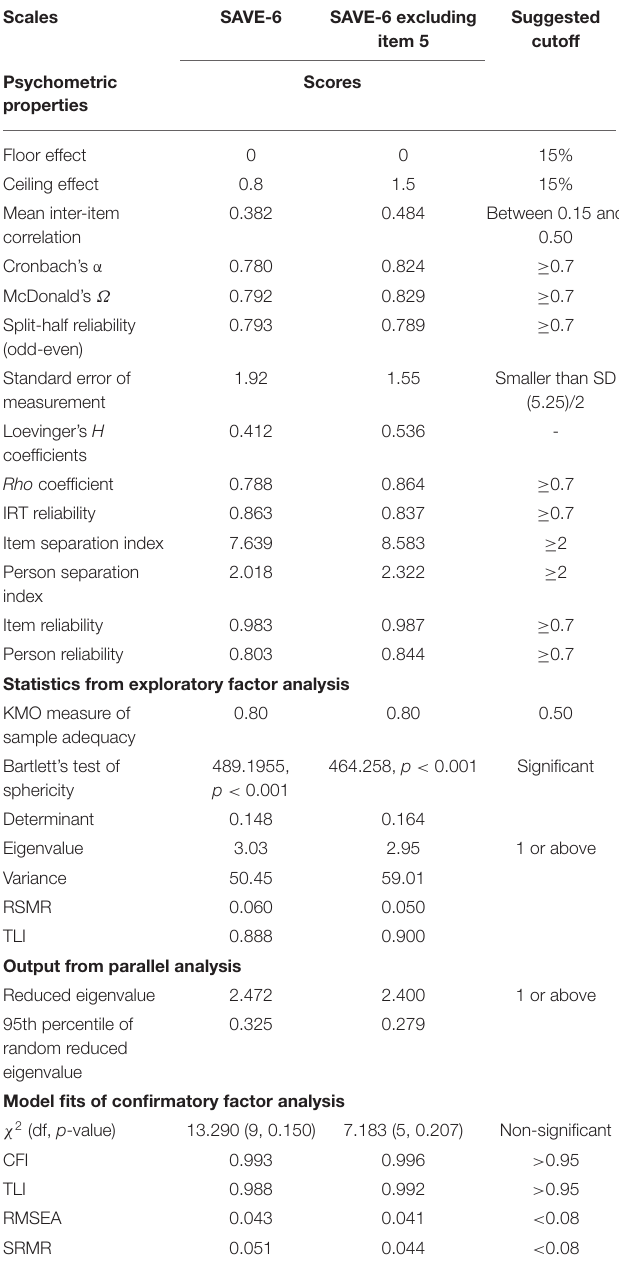
TABLE 3 | Scale-level psychometric properties of the Peruvian Spanish versions of SAVE-6 and SAVE-6 excluding item 5. Scales SAVE-6 SAVE-6 excluding